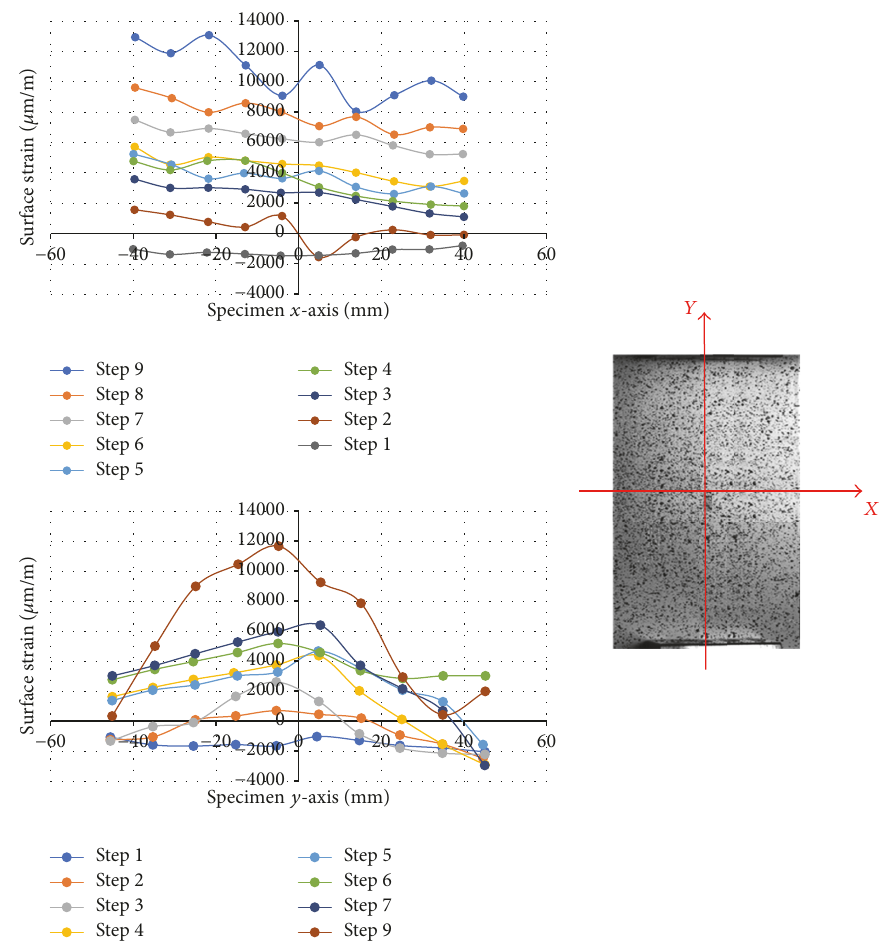
Figure 13: Surface strain-principal values along symmetry axes-side delamination